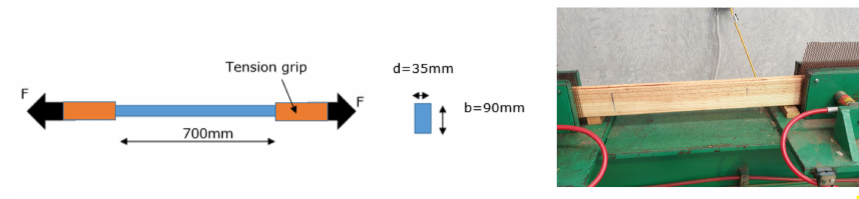
Figure 7. Tension test configuration.